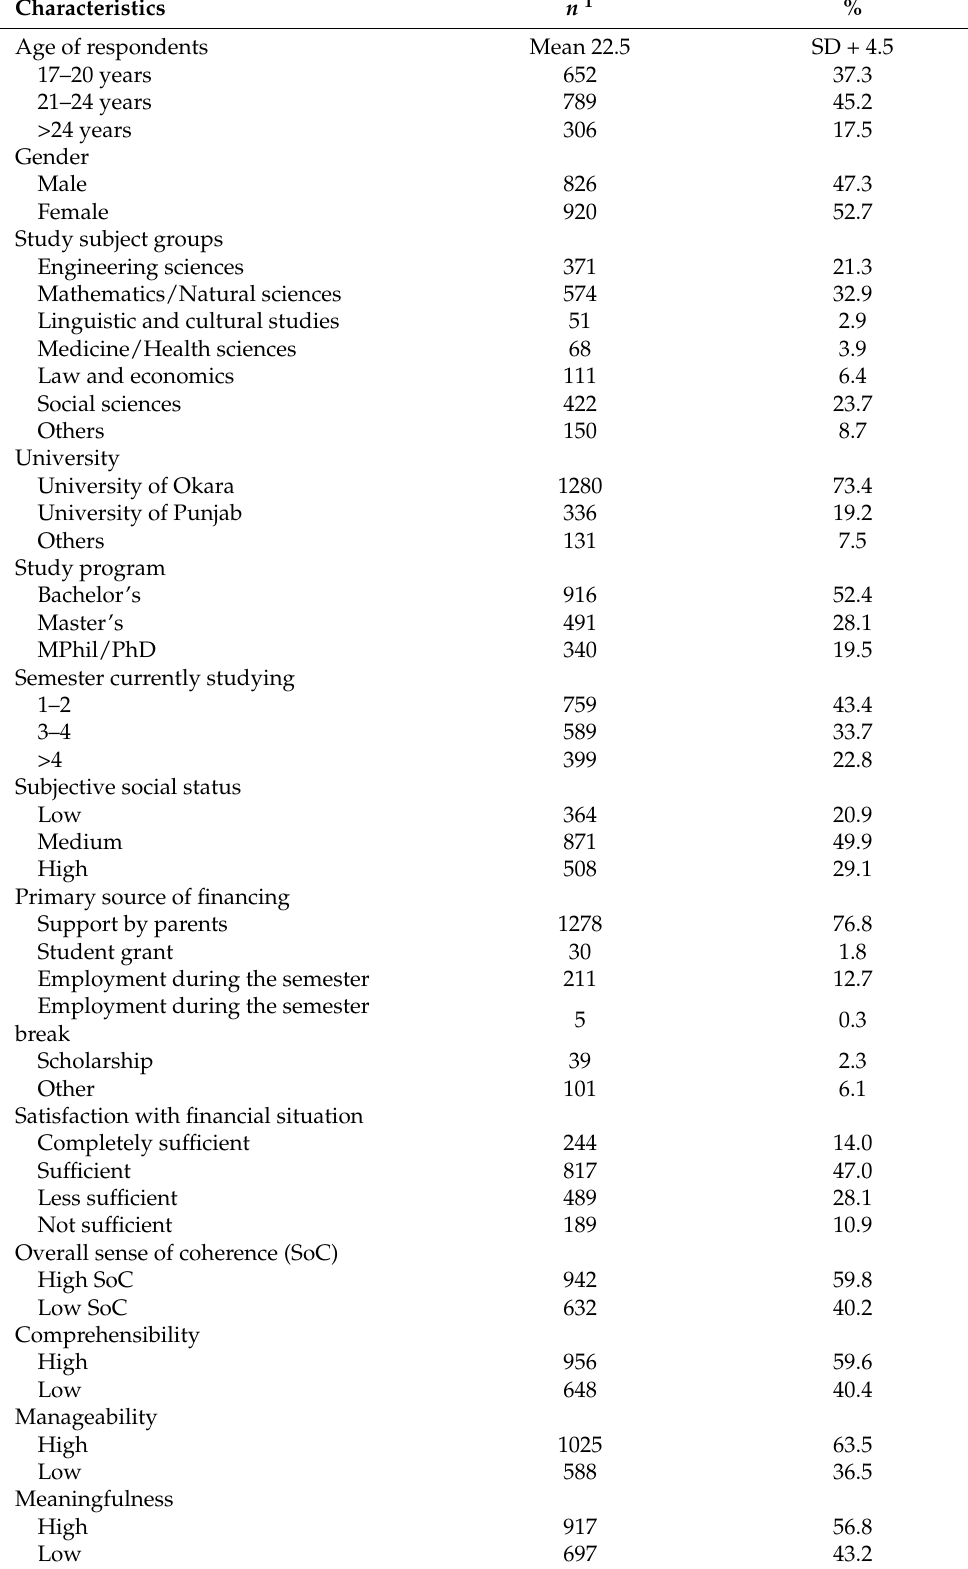
Table 1. Characteristics of respondents ( n =